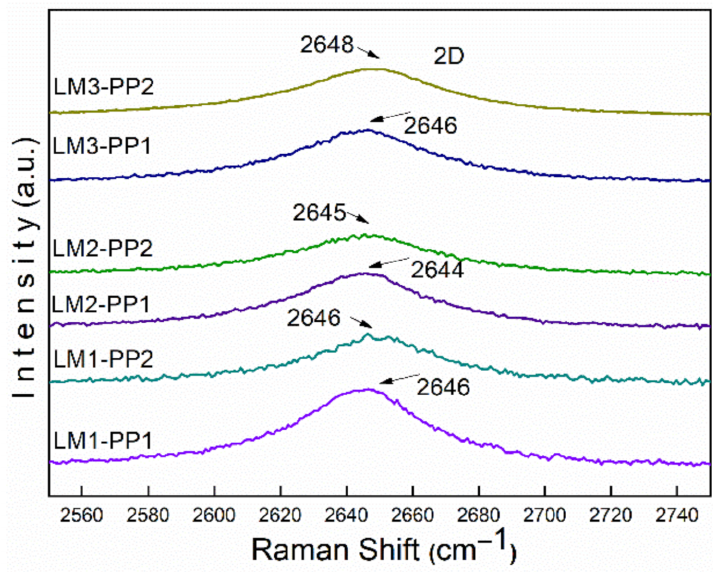
Figure 14. 2D band comparison of the processes PP1 and